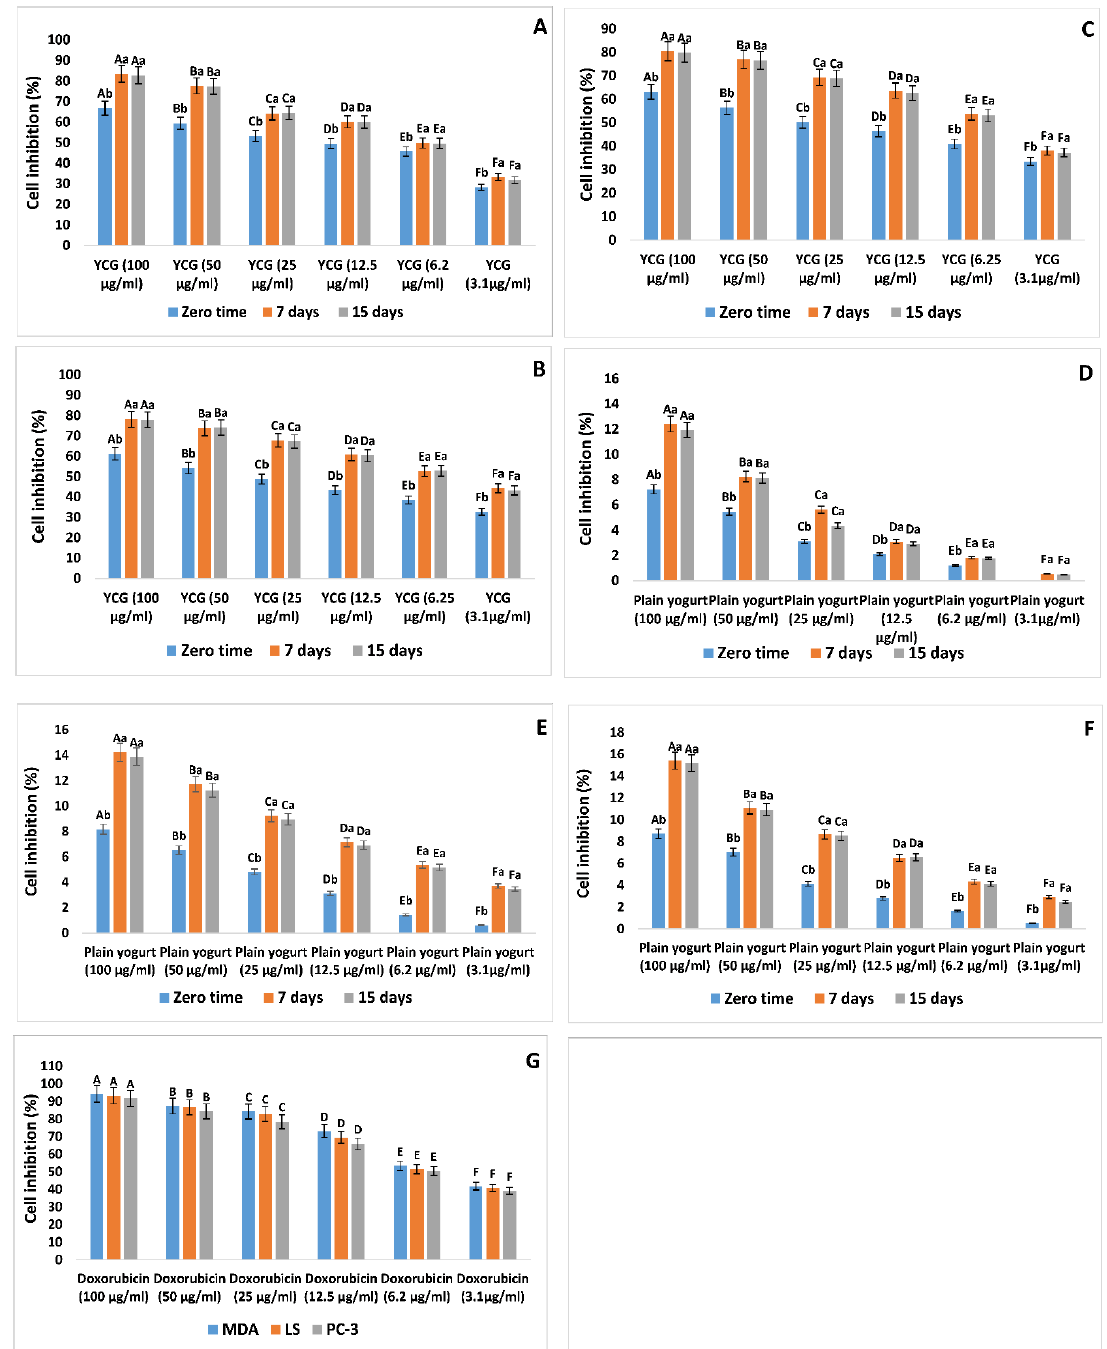
Figure 2. Comparison of the inhibition percentage between different types of postbiotics with different concentrations against tumor cells. Where ( A , D ), ( B , E ) and ( C , F ) for breast (MDA-MB231), colon (LS-174T), and prostate (PC-3) cell lines, respectively. Besides, ( G ) for positive control (Doxorubicin). Different uppercase superscripts point out significant ( p < 0.05) differences between the values for different concentrations. Different lowercase superscripts point out significant ( p < 0.05) differences between the values during the storage period. Vertical bars present the standard division of the treatment